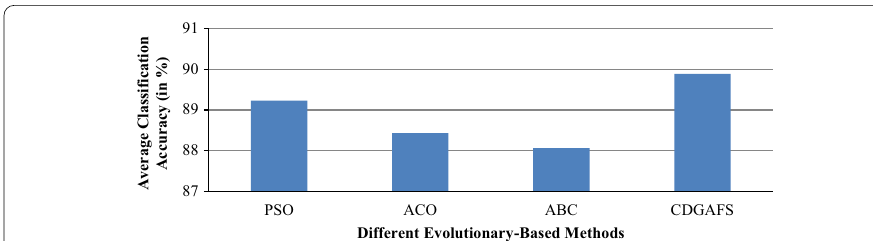
Fig. 3 Average classification accuracy over all datasets on the KNN classifier